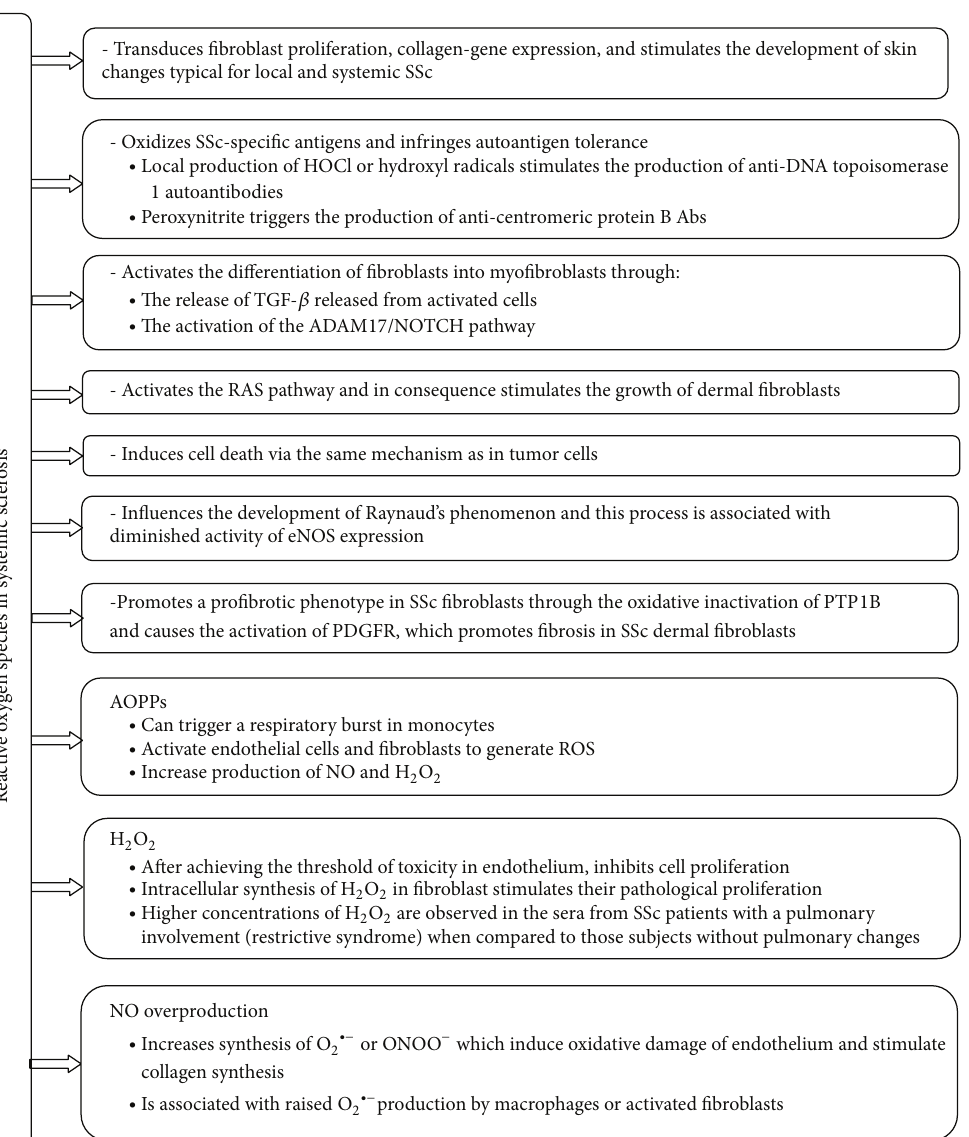
by protein tyrosine phosphatases (PTPs), including